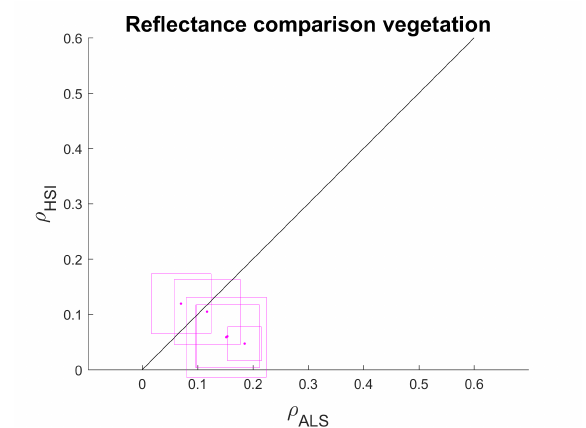
Figure 12: Reflectance comparison for high vegetation. The size of the purple squares corresponds to the area covered by the sin- gle vegetated